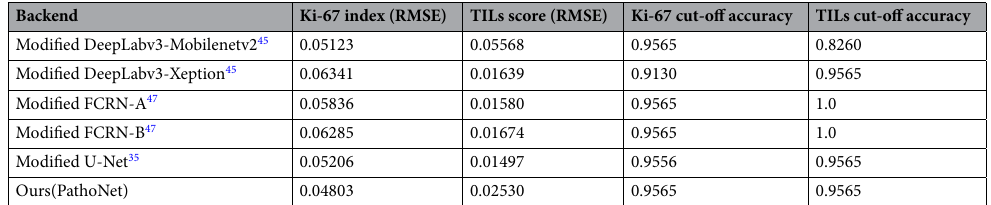
Table 4. RMSE and aggregated cut-off accuracy. Here, Ki-67 index and TILs score estimation were evaluated in terms of root mean squared error (RMSE) and classification accuracy of cut-offs presented for Ki-67 and TILs using the proposed pipeline on the test